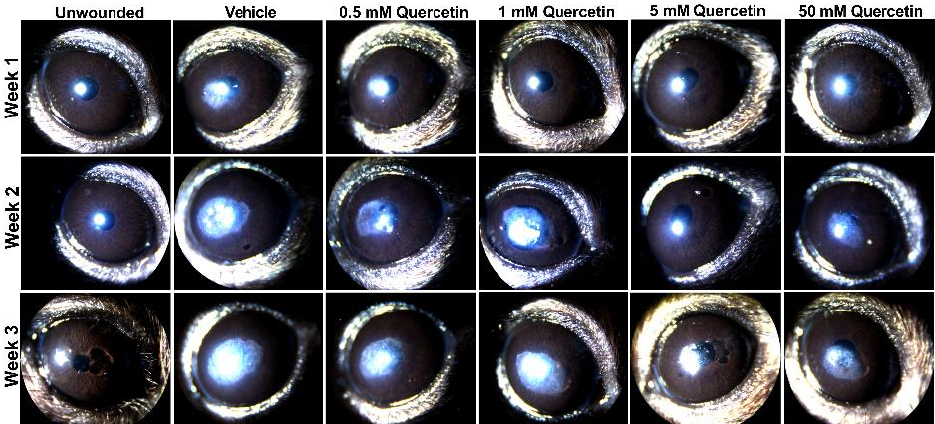
Figure 2. Slit lamp images of mouse corneas at weeks 1, 2, and 3 following corneal debridement. Four concentrations of quercetin (0.5, 1, 5, and 50 mM) in 10% DMSO (vehicle) were tested and topically applied to the cornea immediately post-debridement. Representative images shown for each treatment group (n = 4 eyes for each quercetin concentration, n = 2 unwounded eyes, and n = 2 eyes with vehicle-treatment in this experiment). Previous studies evaluating vehicle effects (n = 3) and a lower dose of quercetin treatment (50 μ m, n = 3) are shown in the Supplemental Materials. To quantify the severity of the corneal scars that developed from weeks 1 through 3 post-injury in the mouse model, clinical scoring of corneal haze was performed by trained staff blinded to treatment groups. At the week 1 timepoint, the higher concentration (50 mM quercetin) was associated with a significant 2.2-fold reduction in scar severity compared to the vehicle-treated group (mean difference = 1.8, 95% confidence interval (CI) [0.2663 to 3.400], p = 0.017, Figure 3). While both high-dose quercetin-treated groups